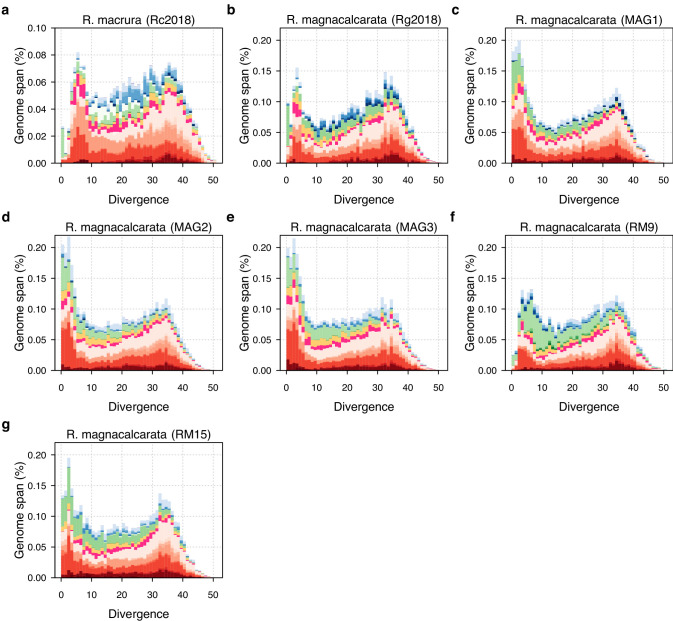
TE divergence landscapes for individual R. macrura and R. magnacalcarata genomes.